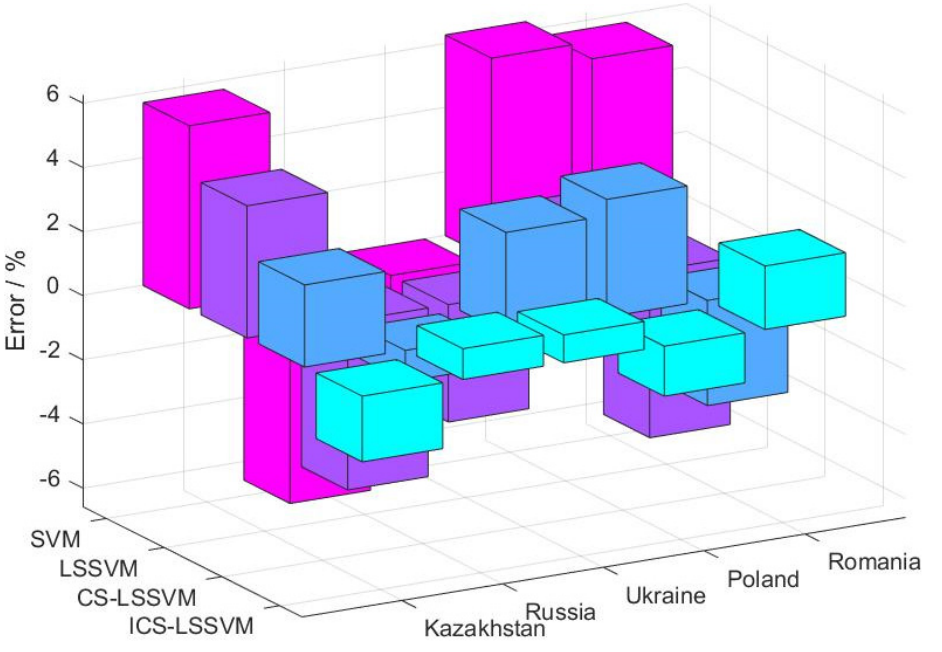
Figure 4. Comparison of relative errors.